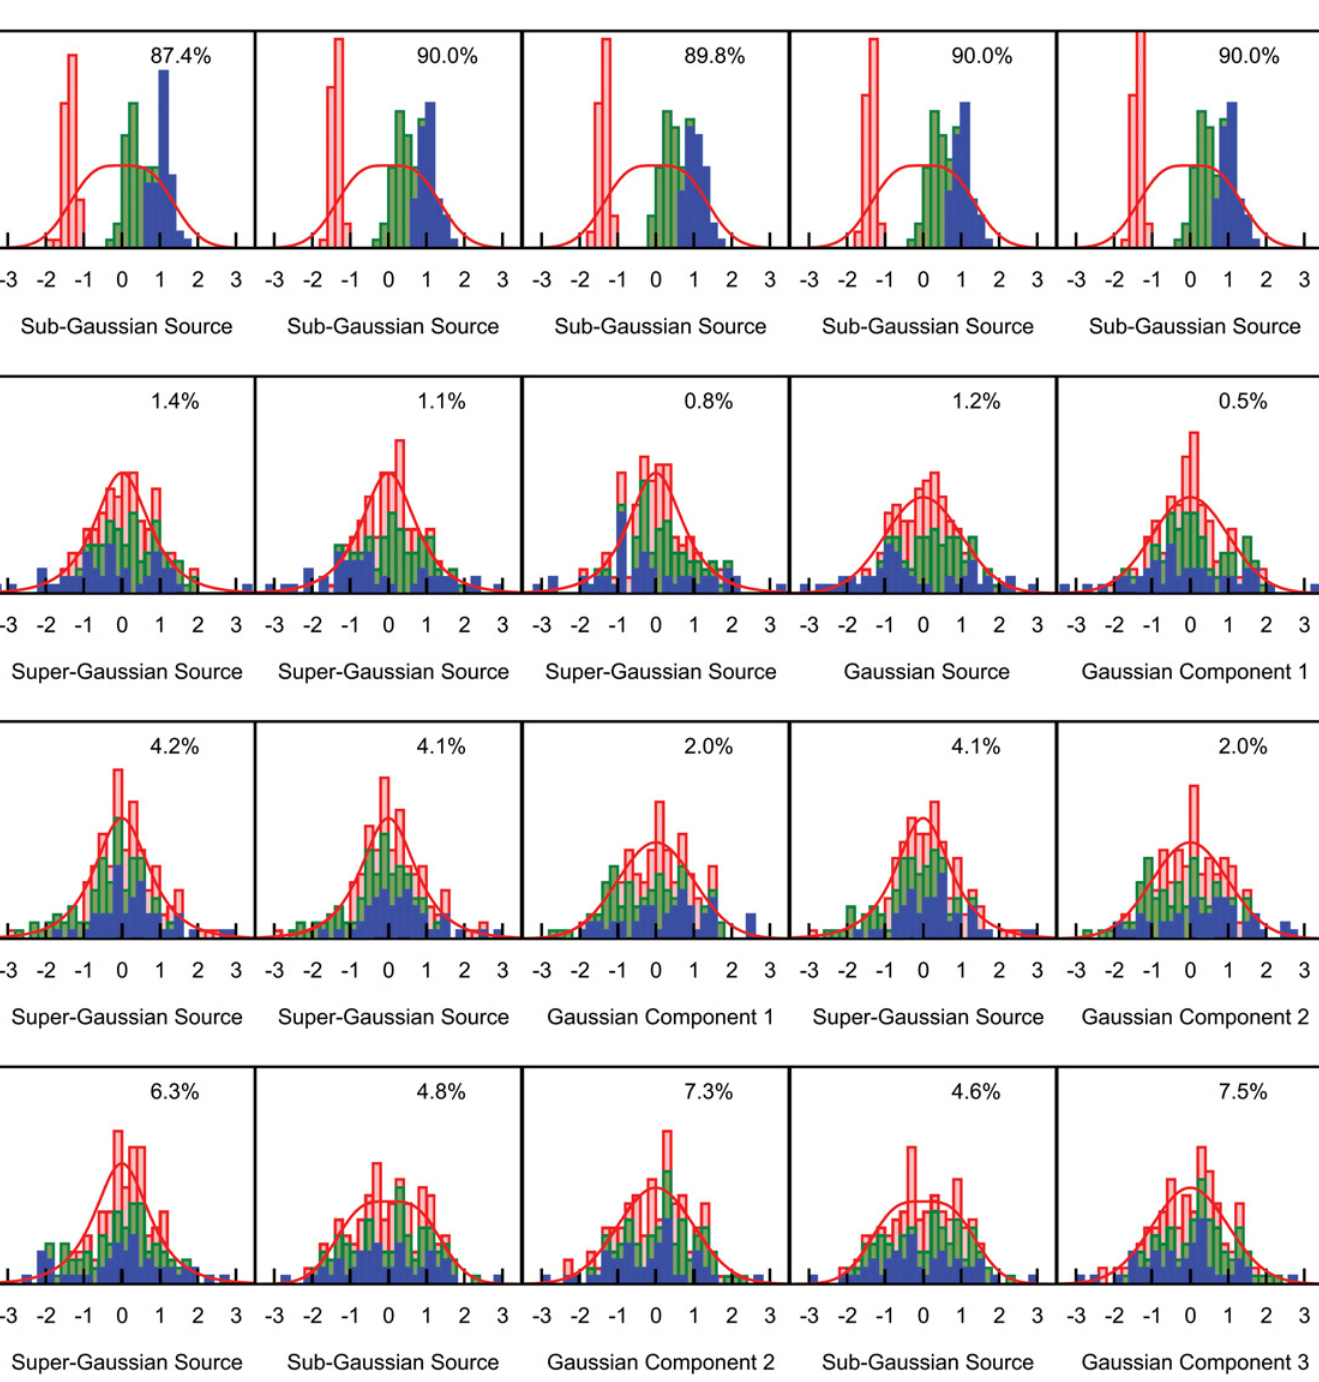
PLOS ONE | DOI:10.1371/journal.pone.0118877 March 26, 2015 16 /